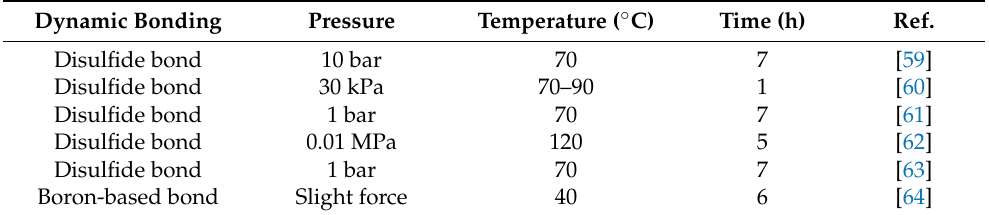
Table 1. External pressure assistant self-healing polymers based on dynamic covalent